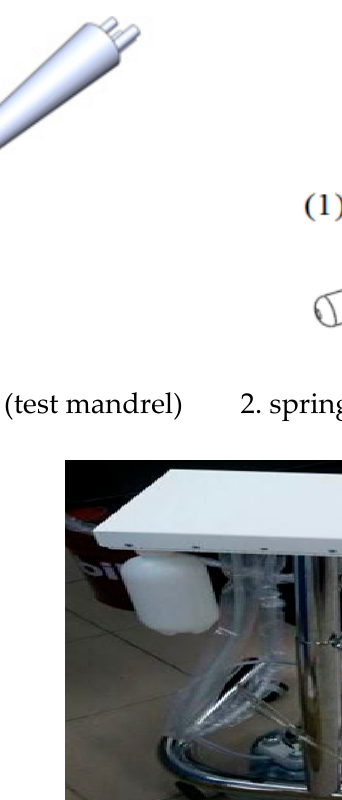
Figure 7. Schematics of up-milling ( left ) and down-milling ( right ). Figure 8. Schematic of the cutting path for one cycle. Two new dental handpieces were used in the experiment. After dental handpiece No. 1 completed 250 cycles (5000 min) of the cutting experiment, it did not reflect clear degra- dation characteristics in the time- or frequency-domain analyses. Considering the reliabil- ity factors of handpiece production, the cutting experiment was continued. To quicken the degradation of the aforementioned dental handpiece, after approximately 300 cycles, the conditions of the cutting experiment were altered. The cutting feed rate was reduced to 30 mm/min; the air pressure was decreased to 45 psi; the cutting depth was increased from 0.1 to 0.2 mm; the cutting width was 0.3 mm; and the cutting process involved only down- milling. The reason why the cutting depth and width were increased was that incomplete